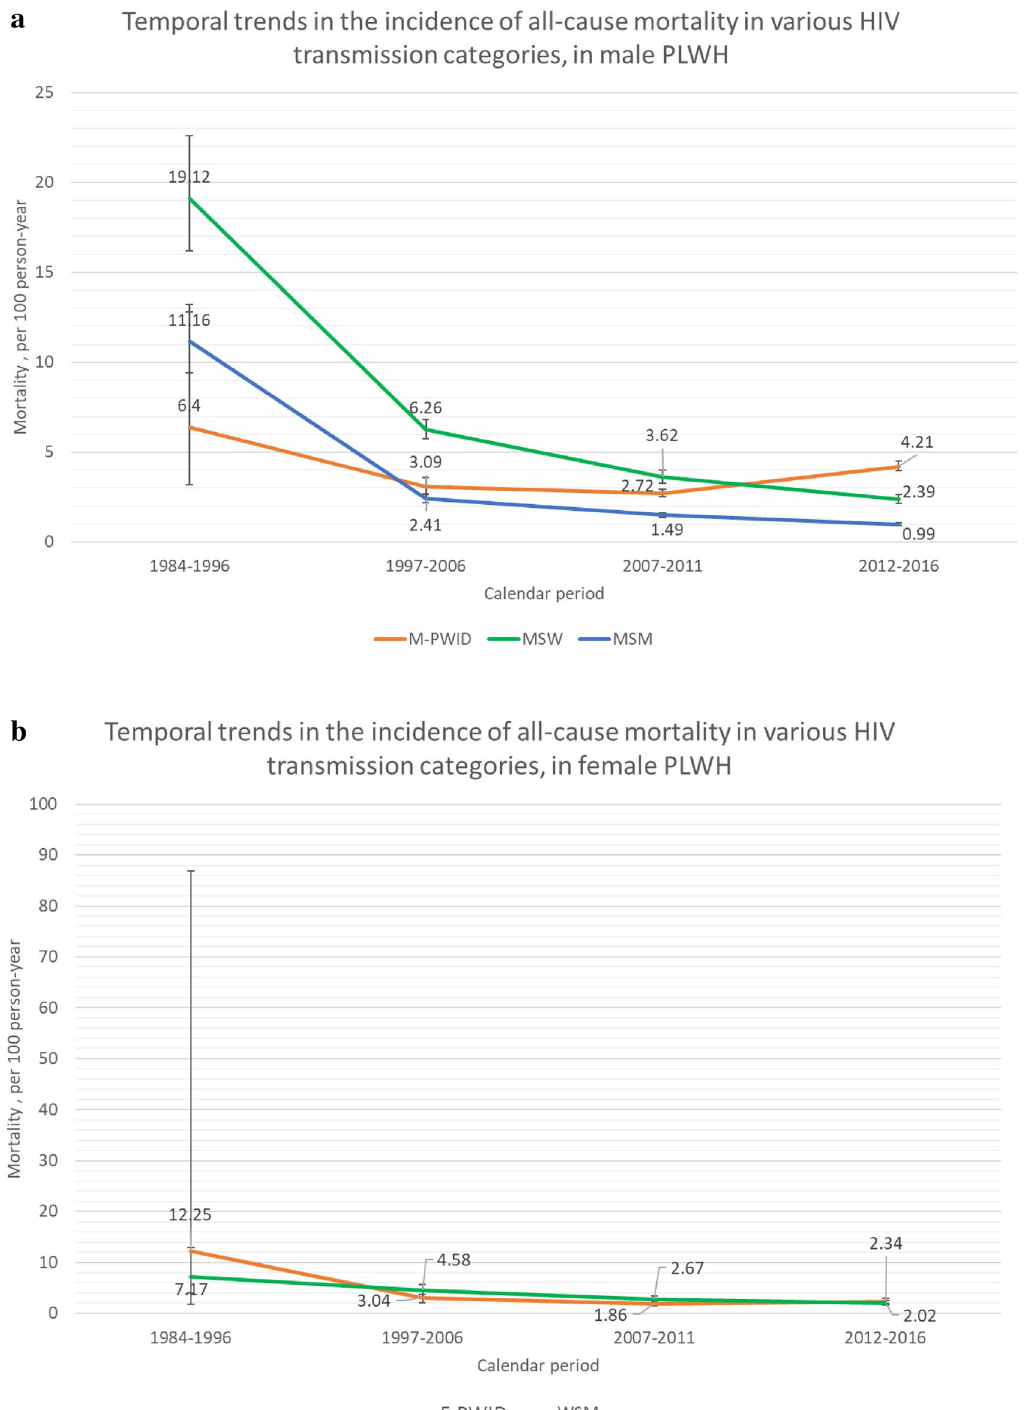
Figure 3. Temporal trends in the incidence of mortality (100 person-years) in various HIV transmission categories from 1984 to 2016 in ( a ) male PLWH and ( b ) female PLWH. Abbreviations: F-PWID, female persons who inject drugs; HIV, human immunodeficiency virus; PWID, persons who inject drugs; M-PWID, male persons who inject drugs; MSM, men who have sex with men; MSW, men who have sex with women; PLWH, persons living with HIV; WSM, women who have sex with